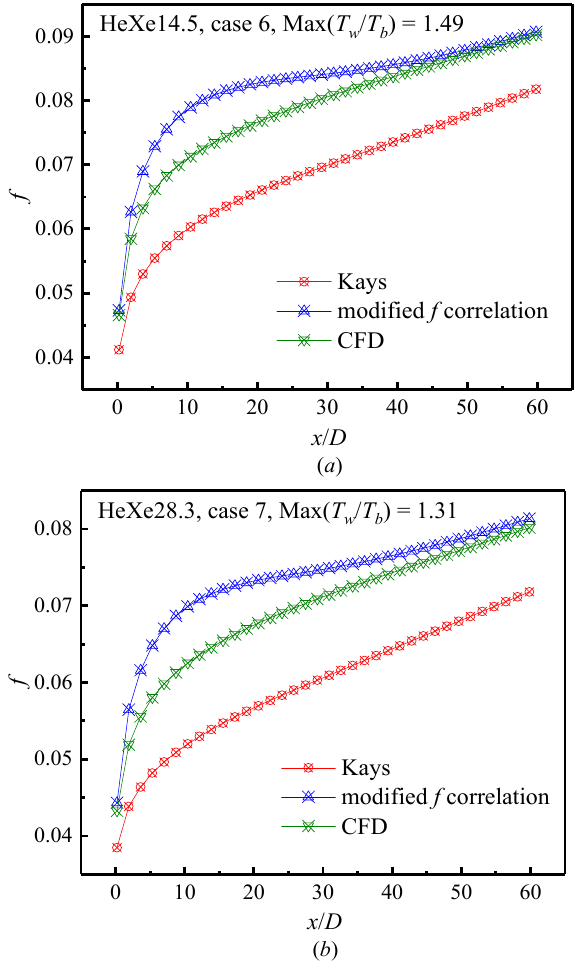
Figure 13. Applicability of the modified f correlation to He–Xe. ( a ) case 6; ( b ) case 7.